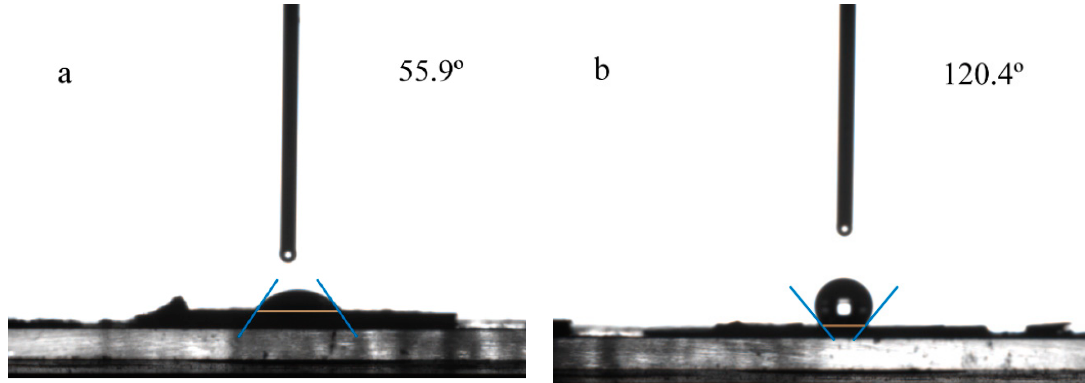
Figure 2. Contact angle images: ( a ) unmodified CI particles; ( b ) Si-CI